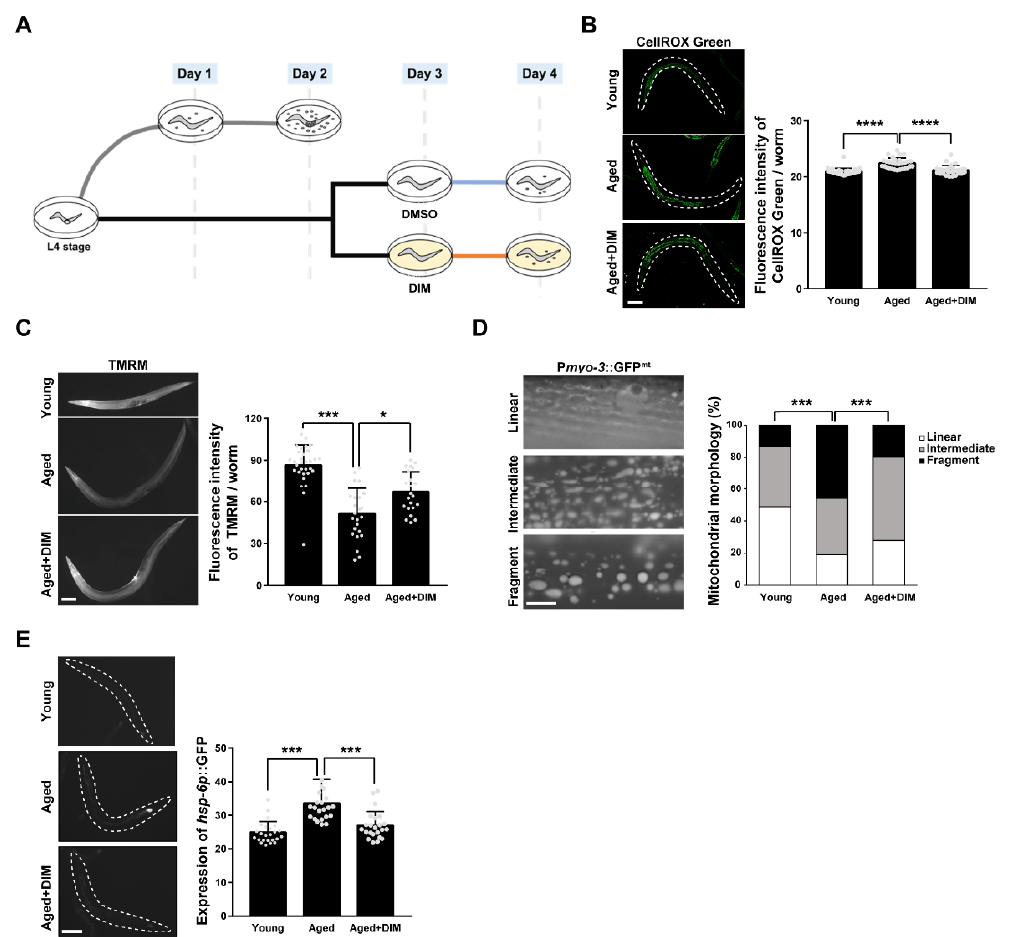
Figure 1. 3,3’ ‐ Diindolylmethane (DIM) supplementation improved mitochondrial function in Cae ‐ norhabditis elegans : ( A ) The experimental scheme for the effect of DIM supplementation on repro ‐ ductive capacity. ( B ) Representative images and a quantification graph of mitochondrial reactive oxygen species (mtROS) levels using CellROX Green staining were shown in wild ‐ type N2 at the day 1 adult stage (Young, n = 30) and wild ‐ type N2 supplemented with DMSO (Aged, n = 30) or DIM (Aged+DIM, n = 30) at the day 3 adult stage for 24 h. Error bars represent SD. ****, p < 0.0001 (one ‐ way ANOVA with Tukey’s post ‐ hoc test). ( C ) Representative images and a quantification graph of mitochondrial membrane potential levels using tetramethylrhodamine methyl ester (TMRM) staining were shown in wild ‐ type N2 at the day 1 (Young, n = 31) and day 4 adult stages supplemented with DMSO (Aged, n = 24) or DIM (Aged+DIM, n = 21) for 24 h. Error bars represent SD. *, p < 0.05, ***, p < 0.001 (one ‐ way ANOVA with Tukey’s post ‐ hoc test). ( D ) Representative im ‐ ages and a percentage graph indicate mitochondrial morphology in the muscle using P myo ‐ 3 ::GFP mt transgenic animals at the day 1 (Young, n = 39) and day 4 adult stages supplemented with DMSO (Aged, n = 37) or DIM (Aged+DIM, n = 36) for 24 h. The analysis of mitochondrial morphology was classified into three categories: (1) linear, (2) intermediate, and (3) fragmented. Scale bars represent 10 μ m. ***, p < 0.001 (chi ‐ square test). ( E ) Representative images and quantification graph indicate the levels of expression of hsp ‐ 6p::GFP transgenic animals at the day 1 (Young, n = 24) and day 4 adult stages supplemented with DMSO (Aged, n = 22) or DIM (Aged+DIM, n = 23) for 24 h. Error bars represent SD. ***, p < 0.001 (one ‐ way ANOVA with Tukey’s post ‐ hoc test).